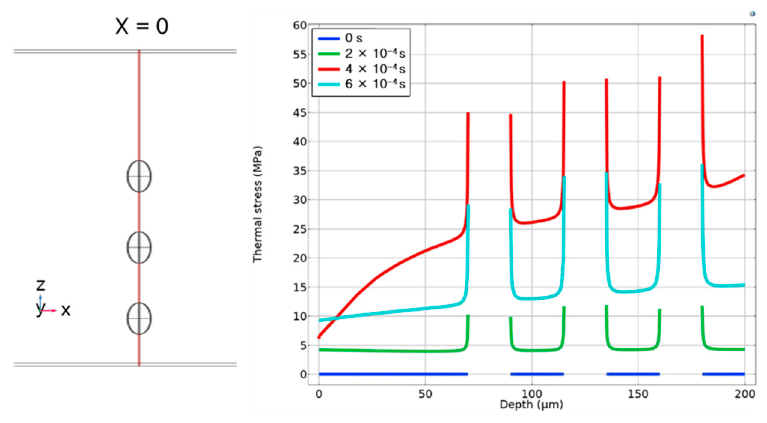
Figure 6. Thermal stress distribution along the z-direction.